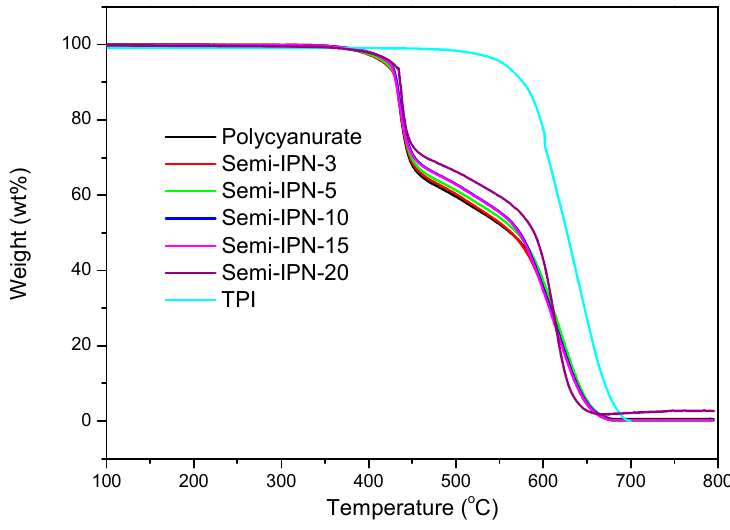
Figure 7. TGA curves of polycyanurate, TPI, and semi-IPNs.